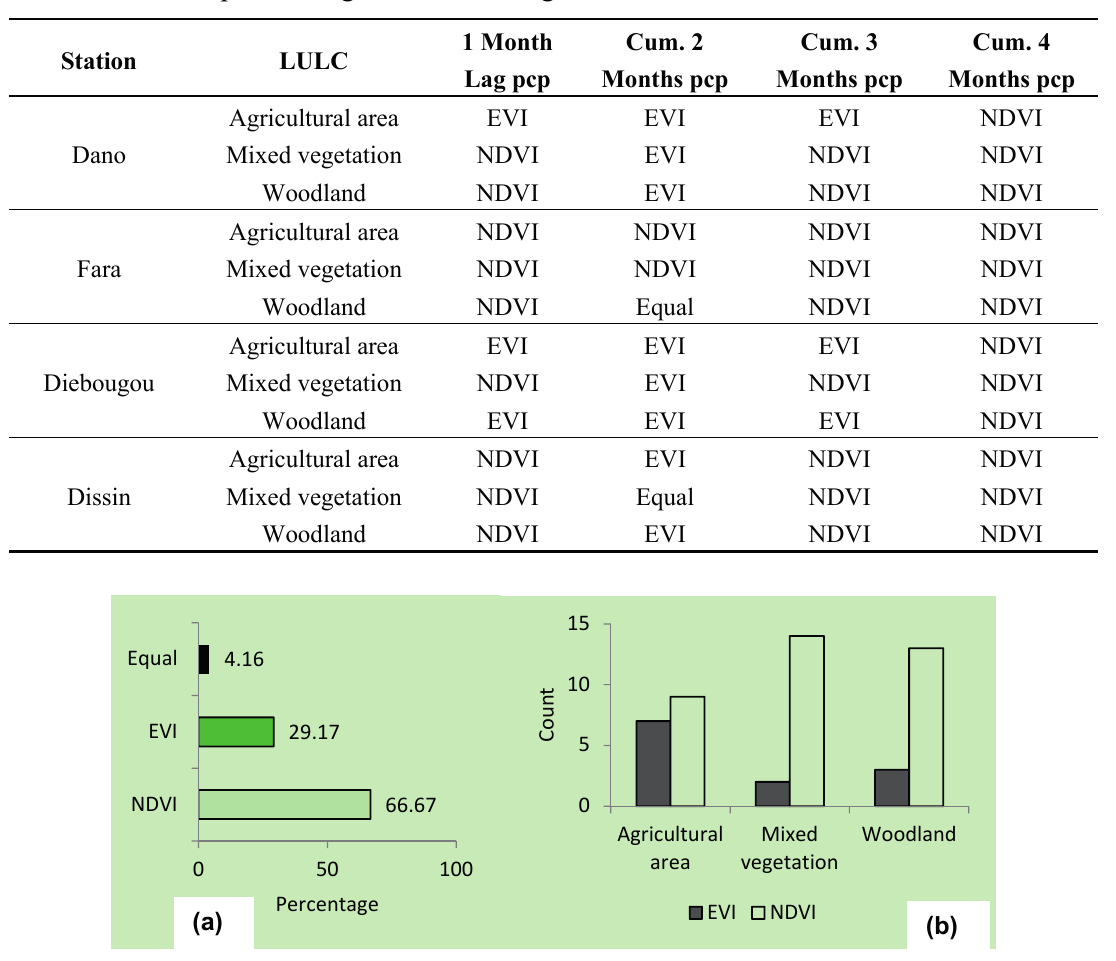
Table 6. Best performing index according to land use/covers and rainfall indicators.